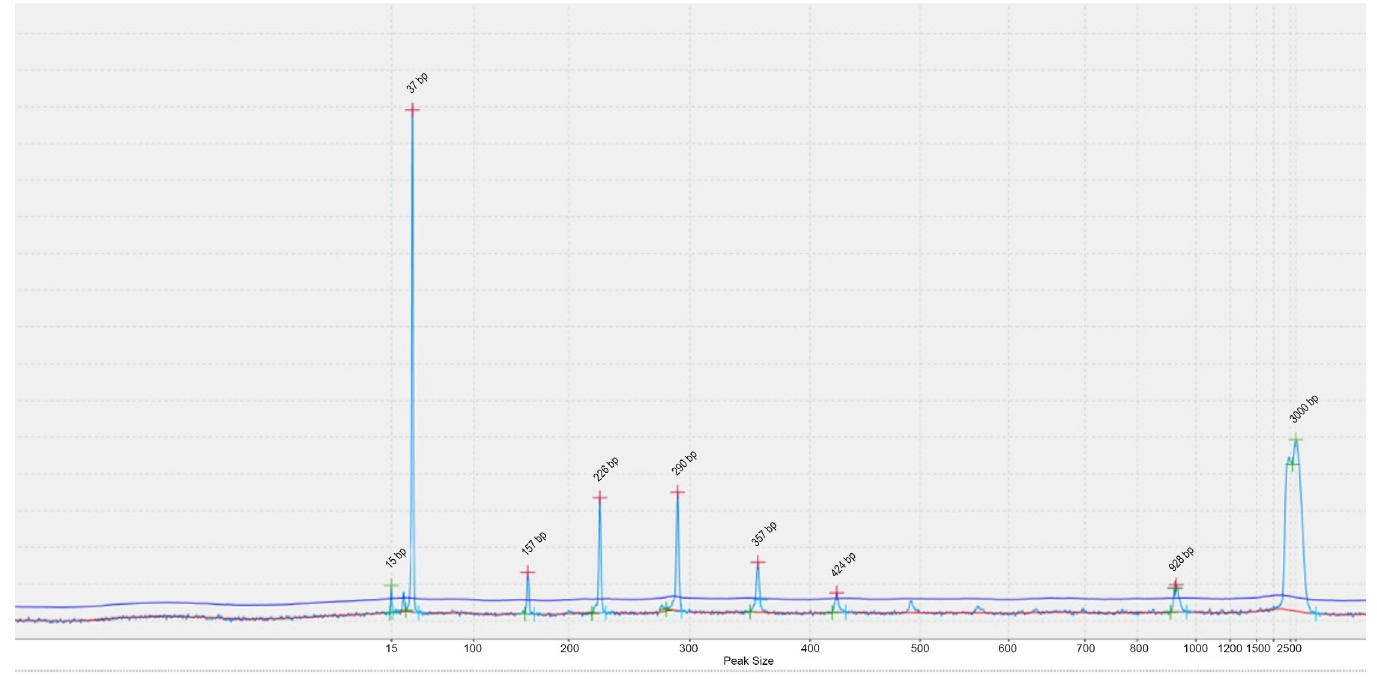
Fig 2. Example of an incorrect Locus 3232 peak calling on the QiaXcel